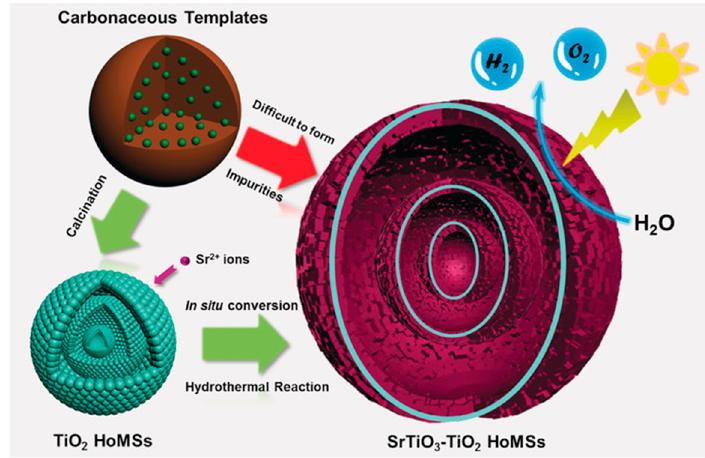
Figure 29. Preparative route of the SrTiO 3 ‐ TiO 2 hollow multi ‐ shelled structures (HoMSs), via a hydrothermal method. Reproduced from [101], with permission from John Wiley and Sons, copyright 2019.